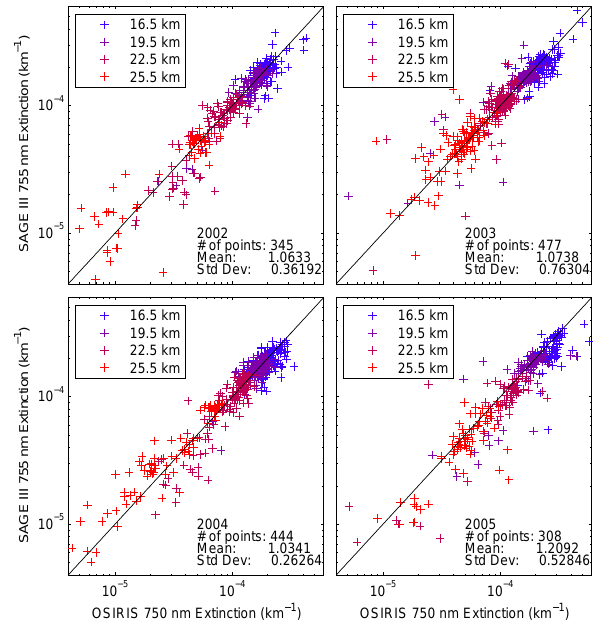
Fig. 4. The mean (solid) and standard deviation (dashed) of the per- cent difference of all OSIRIS and SAGE III coincidences over the four years of mission overlap, 2002–2005. Top left panel shows the results for 117 coincident measurements in 2002; top right panel shows the results for 134 coincident measurements in 2003; bot- tom left panel shows the results for 137 coincident measurements in 2004; and, bottom right panel shows the results for 91 coincident measurements in 2005.